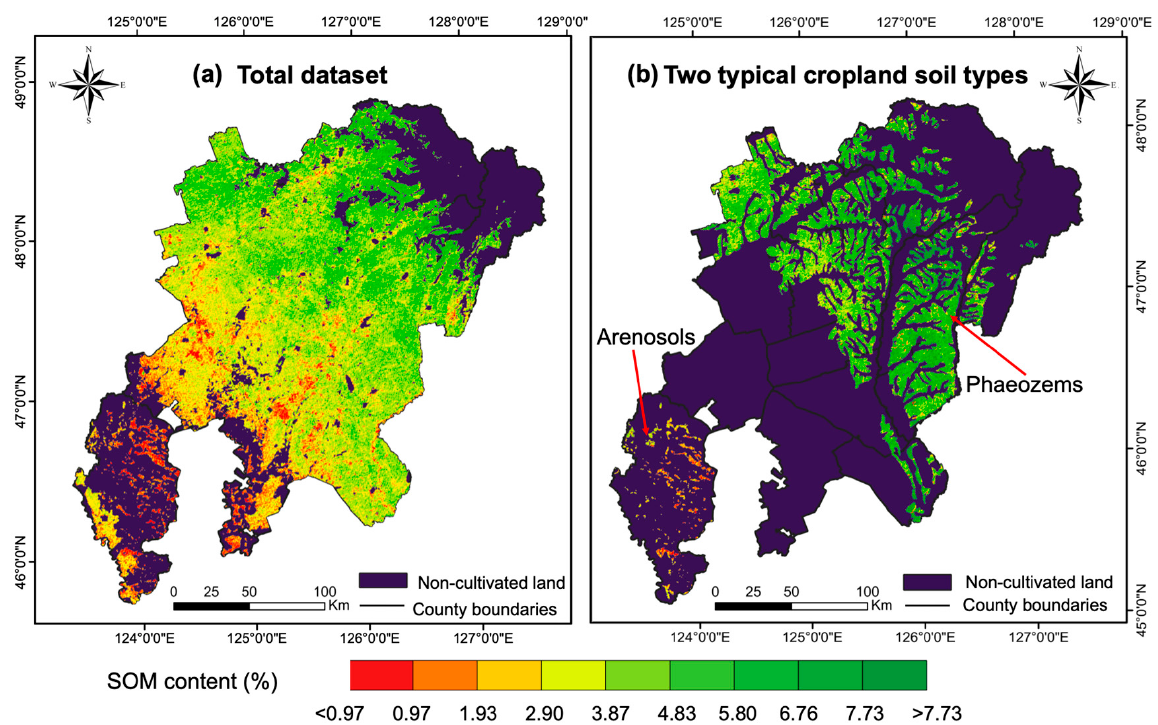
Figure 5. Maps of SOM content in the study area using the total dataset ( a ) and two typical cropland soil types (i.e., Arenosols and Phaeozems) ( b